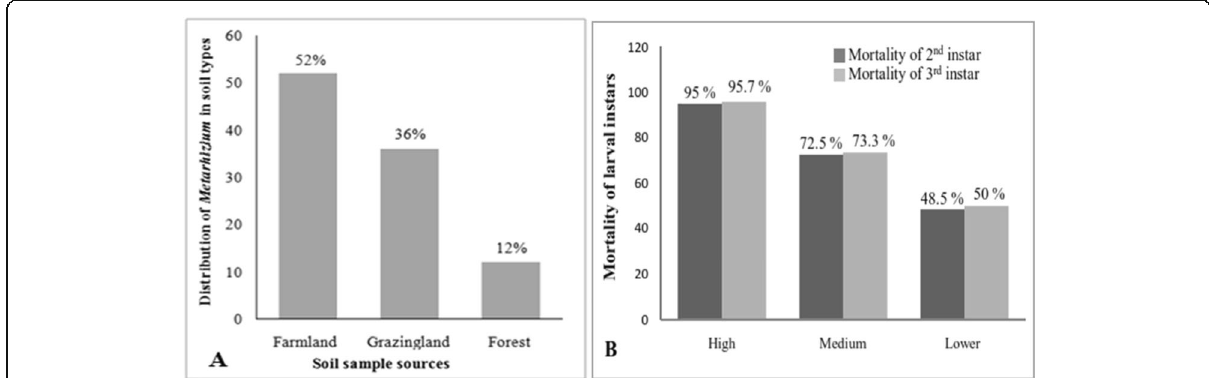
Fig. 2 Distribution of Metarhizium in the soil types ( a ) and summary of Metarhizium pathogenicity potential against 2nd and 3rd larval instars of Tuta absoluta ( b )